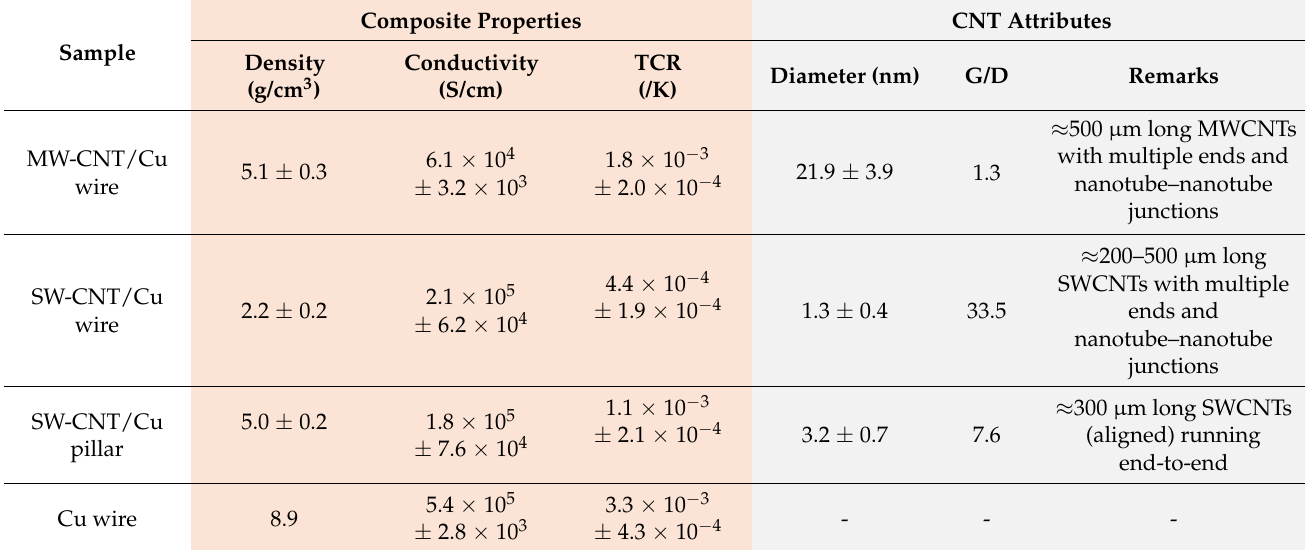
Table 1. Composite properties (density, room temperature electrical conductivity, and TCR) and parent template nanotube characteristics (CNT diameter and